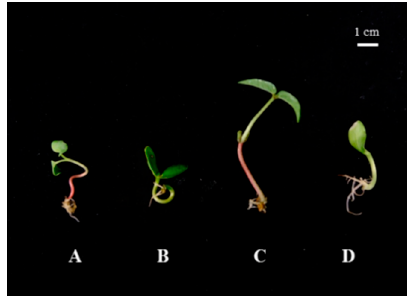
Figure 1. Sprouts of radishes ( A ), soybeans ( B ), mung beans ( C ) and pumpkins ( D ) grown in white lights (WL) 5 d after germination. The sprouts showed morphological differences. The soybean and mung bean sprouts in WL had fleshy cotyledons that were also present when the young leaves appeared, while in radishes and pumpkins, the cotyledons changed into photosynthetic leaflets.